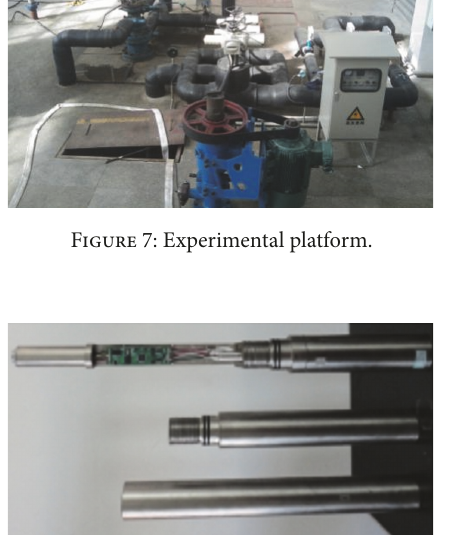
Figure 8: Downhole